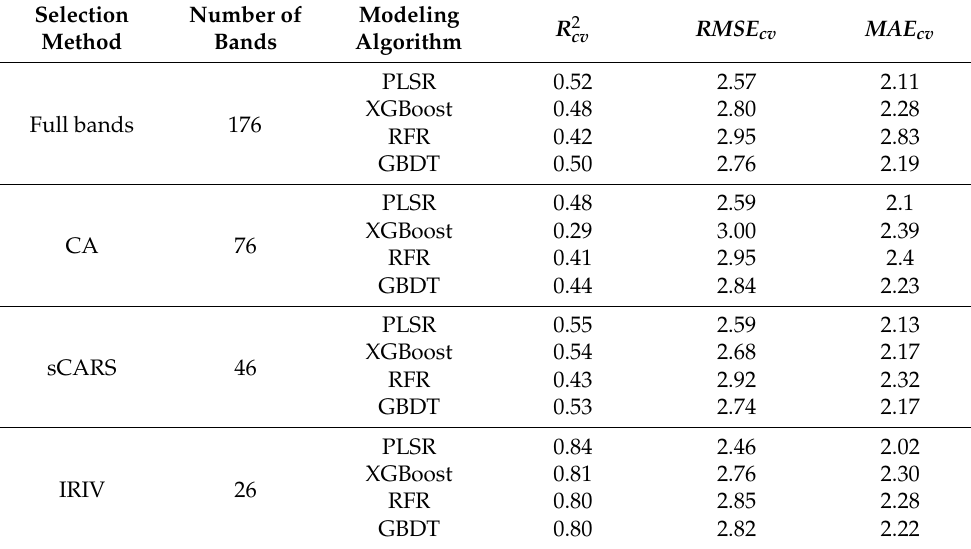
Table 2. Comparison of accuracy of different